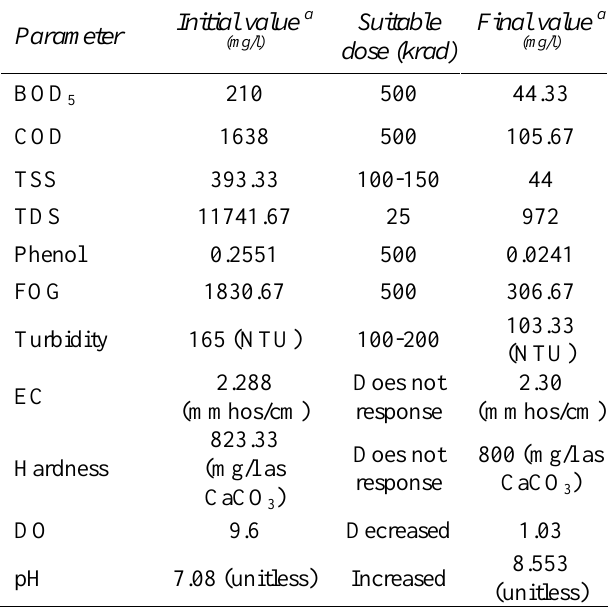
Table 3: Suitable Radiation dose to minimize each parameter to accepted